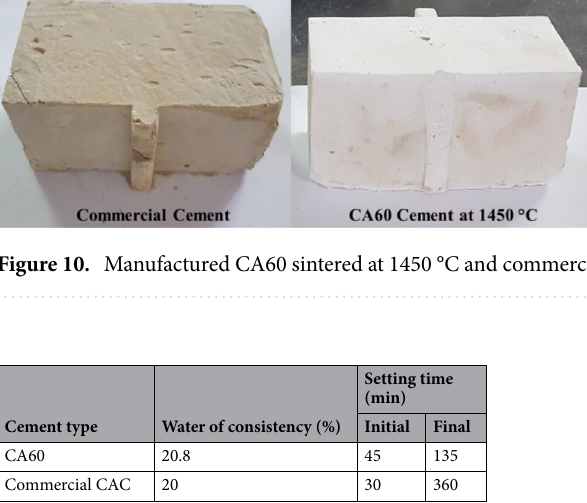
Table 4. Water of consistency and setting time of the manufactured and commercial